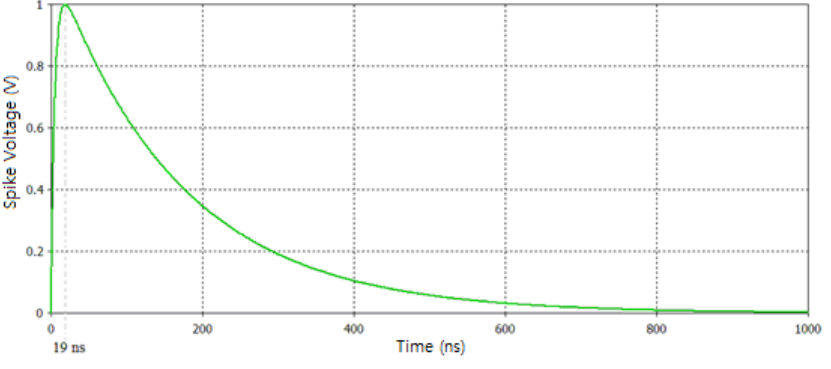
Figure 2. Simulated waveform for pulse.